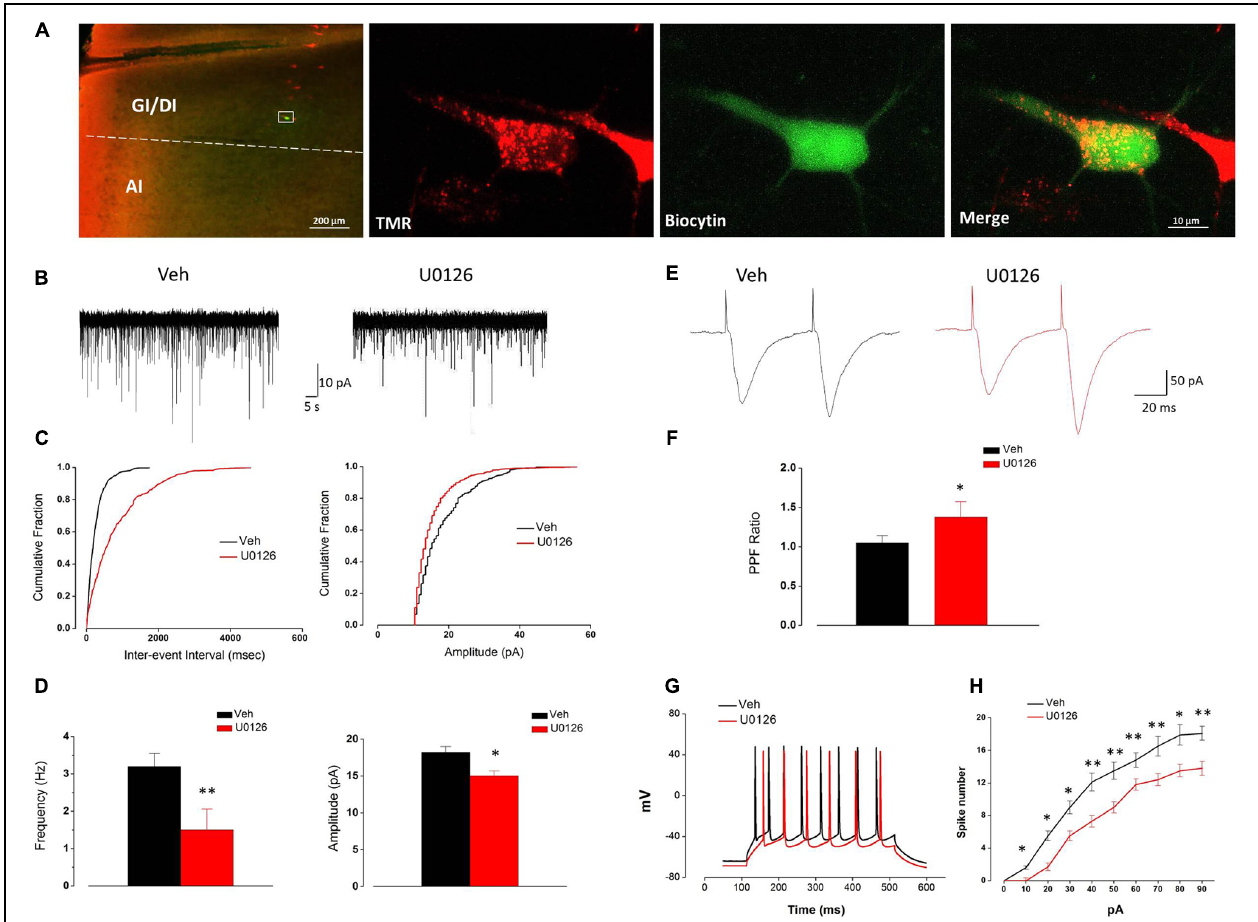
FIGURE 5 | The activity of Vc-projecting neurons in the IC of IoN-CCI rats was effectively impaired by U0126 (5 mM) perfusion. (A) A representative retrogradely TMR-labeled neuron (red) in the IC was recorded and injected with biocytin (labeled with Alexa 488 (green). The white rectangle area in the first panel is enlarged in the following three panels. (GI, granular insular cortex; DI, dysgranular insular cortex; AI, agranular insular cortex). Scale bar = 200 μ m (left) and 10 μ m (right). (B–D) Superimposed samples and cumulative fraction results showing that U0126 significantly inhibited both the frequency and amplitude of the sEPSCs of Vc-projecting neurons in the IC of IoN-CCI rats. (B,C) Bath application of U0126 (5 mM, 1 h) inhibited the frequency and amplitude of sEPSCs in rats with IoN-CCI. (D) Summary of the effects of U0126 on the sEPSCs of Vc-projecting neurons in IoN-CCI rats (U0126 vs . vehicle, ∗ P < 0.05, ∗∗ P < 0.01; n = 15). (E,F) Effects of U0126 on the PPR of paired EPSCs in IoN-CCI rats. Paired EPSCs were evoked by the delivery of paired pulses with an inter-pulse interval of 50 ms, and the PPR was measured as the ratio of the averaged amplitude of the second EPSC to that of the first EPSC. (E) Traces of paired EPSCs in representative neurons that were perfused with vehicle or U0126. (F) The averaged PPR recorded in the presence of vehicle or U0126 (U0126 vs . vehicle, ∗ P < 0.05; n = 10). (G,H) Sample traces and average results showing that the number of action potentials (APs) in a train induced by the injection of step currents (400 ms, 0–90 pA) was significantly reduced by U0126 in IoN-CCI rats ( n = 15, P < 0.05, two-way repeated measures ANOVA). The Holm-Sidak post hoc test indicated that U0126 decreased the spike number when currents of 10 pA ( t = 2.50, ∗ P < 0.05), 20 pA ( t = 2.62, ∗ P < 0.05), 30 pA ( t = 2.34, ∗ P < 0.05), 40 pA ( t = 3.34, ∗∗ P < 0.01), 50 pA ( t = 2.50, ∗∗ P < 0.01), 60 pA ( t = 3.34, ∗∗ P < 0.01), 70 pA ( t = 3.62, ∗∗ P < 0.01), 80 pA ( t = 2.57, ∗ P < 0.05), and 90 pA ( t = 5.07, ∗∗ P < 0.01) were